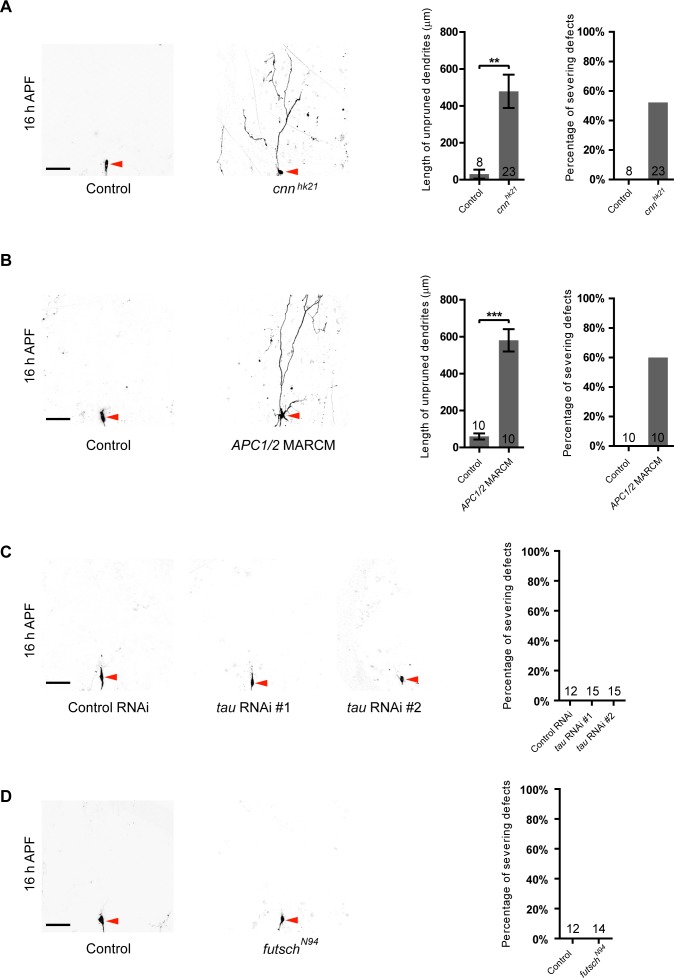
CNN and APC1/2 appear to be required for dendrite pruning of ddaC neurons.(A–D) Live confocal images of ddaC neurons expressing mCD8-GFP driven by ppk-Gal4 at 16 hr APF. (A–B) While the control neurons pruned all the dendrites, cnnhk21 neurons (A), or APC2N175K, APC1Q8 double MARCM (B) ddaC clones exhibited dendrite pruning defects at 16 hr APF. (C–D) ddaC neurons overexpressing tau RNAi #1, #2 (C), or futschN94 (D) ddaC neurons exhibited normal dendrite pruning at 16 hr APF. Red arrowheads point to the ddaC somas. Bar charts on the right depict quantification of total length of unpruned ddaC dendrites and/or the severing defects at 16 hr APF. Scale bars represent 50 μm. Error bars represent SEM. The number of samples (n) in each group is shown on the bars. **p<0.01; ***p<0.001 as assessed by two-tailed Student’s T test.10.7554/eLife.39964.035Figure 8—figure supplement 3—source data 1.Extended statistical data as Microsoft Excel spreadsheet.